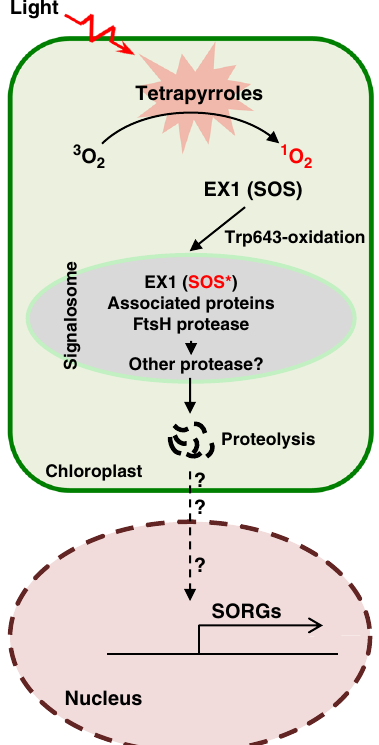
Fig. 6 EX1-mediated 1 O 2 signaling. Free tetrapyrrole molecules such as chlorophyll and its precursors are potential sources of 1 O 2 generation. In the fl u mutant, 1 O 2 oxidizes the Trp643 residue in the SOS domain of EX1. The oxidized EX1 protein, perhaps also EX1-associated proteins, is recognized by the signalosome where the thylakoid membrane-bound FtsH protease promotes EX1 degradation. This process is a prerequisite for initiating the 1 O 2 signaling. The degradation of EX1 and possibly its associated proteins may release a yet unknown retrograde signaling molecule, which induces the expression of